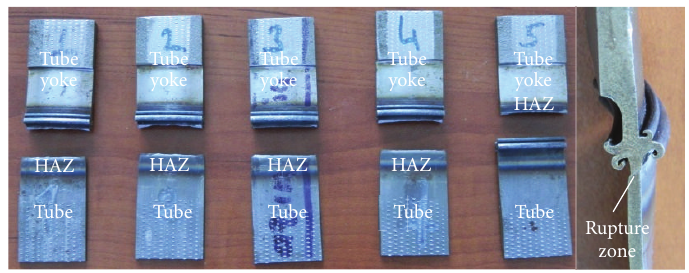
Figure 9: Tensile test samples after tensile test.